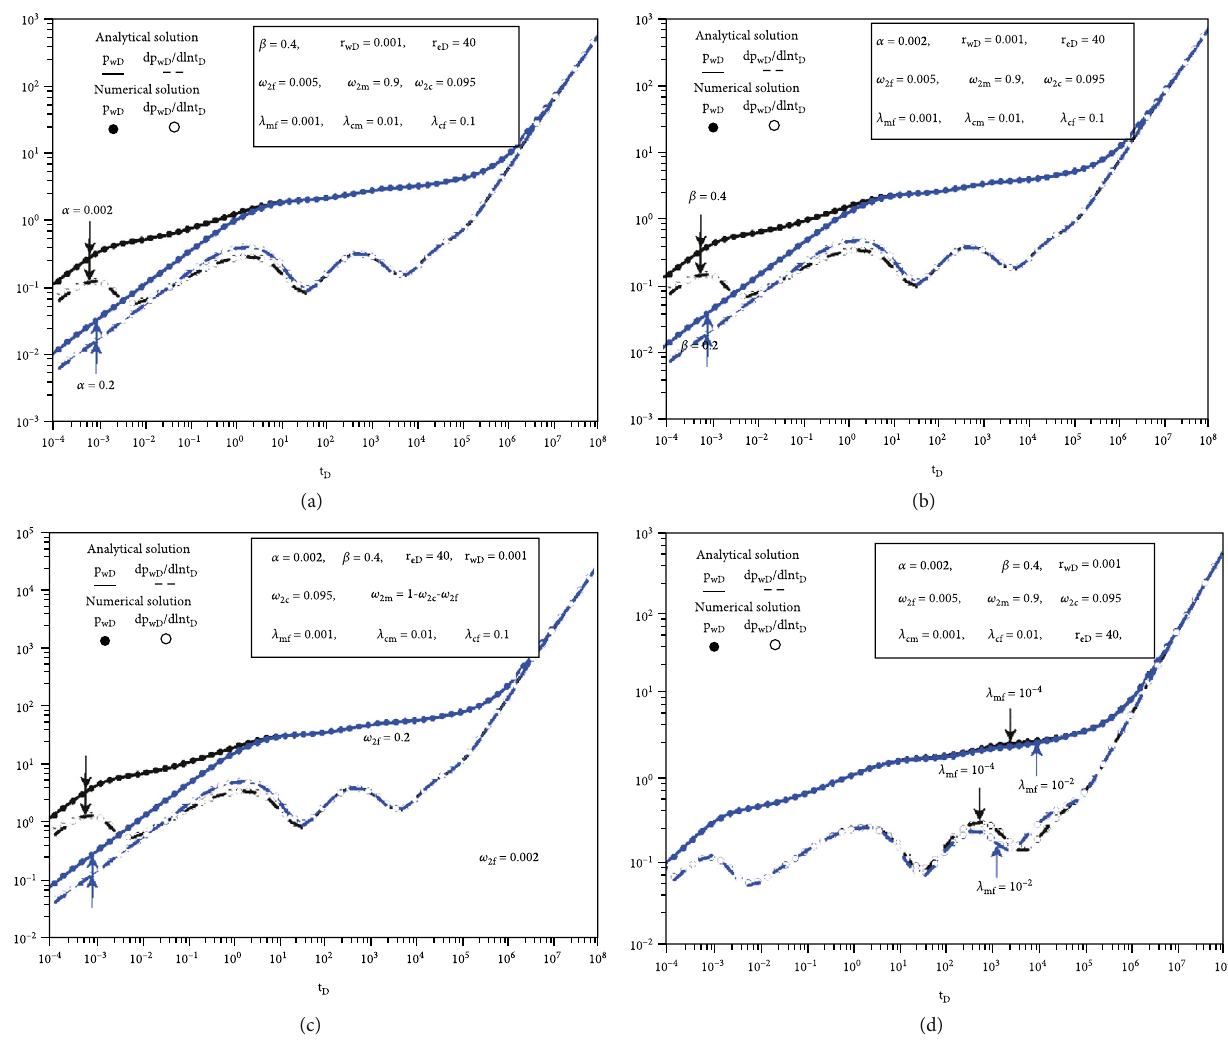
Figure 5: Comparison of analytical solution and numerical solution of bottomhole pressure in a compound reservoir model under di ff erent parameters ((a) interzonal di ff usivity ratio: 0.002, 0.2; (b) interzonal conductivity ratio: 0.2, 0.4; (c) elastic storability ratio of natural fracture system: 0.002, 0.2; (d) matrix-fracture cross fl ow coe ffi cient: 10 -4 , 10 -2 ).